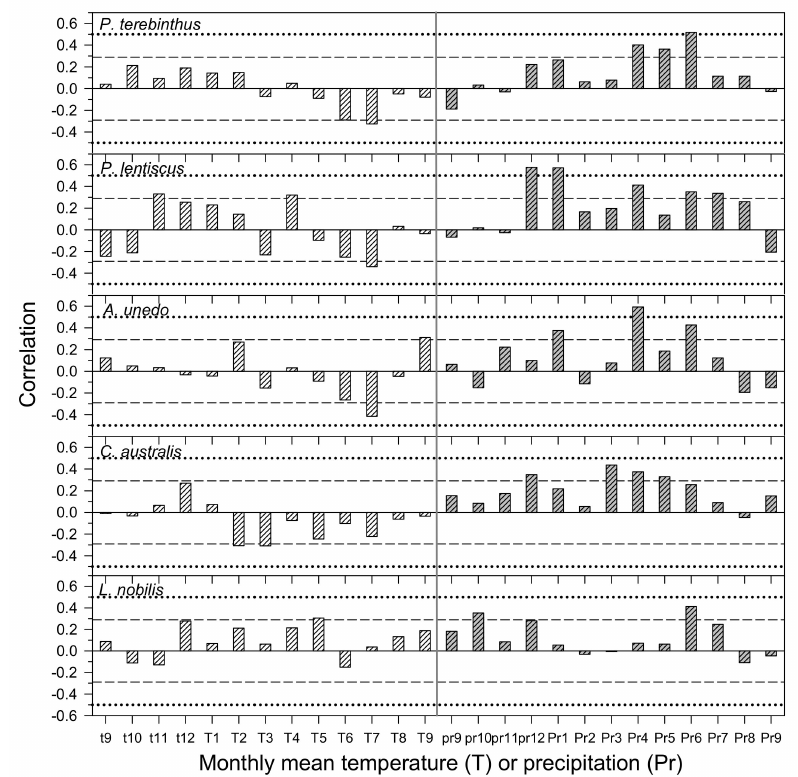
Figure 3. Pearson correlations between monthly climate variables ( x axis) and mean series of ring-width indices of the five study species. The climate variables (T, temperature, white bars; Pr, precipitation, grey bars) are abbreviated by lowercase and uppercase letters corresponding to the previous and current years, respectively. Current year is the year of ring formation. Numbers indicate months. Dashed and dotted horizontal lines correspond to the 0.05 and 0.01 significance levels,